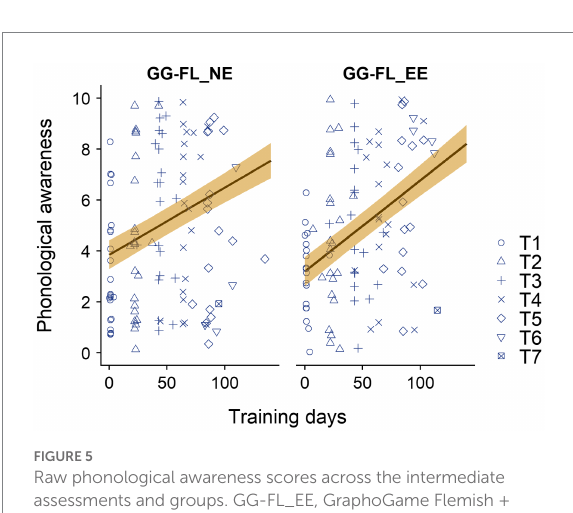
FIGURE 5 Raw phonological awareness scores across the intermediate assessments and groups. GG-FL_EE, GraphoGame Flemish + envelope enhancement group; GG-FL_NE, GraphoGame Flemish + non-enhanced group; and T1-T7, trial 1–7. The solid lines and their yellow shades represent the estimated linear model slopes and their standard